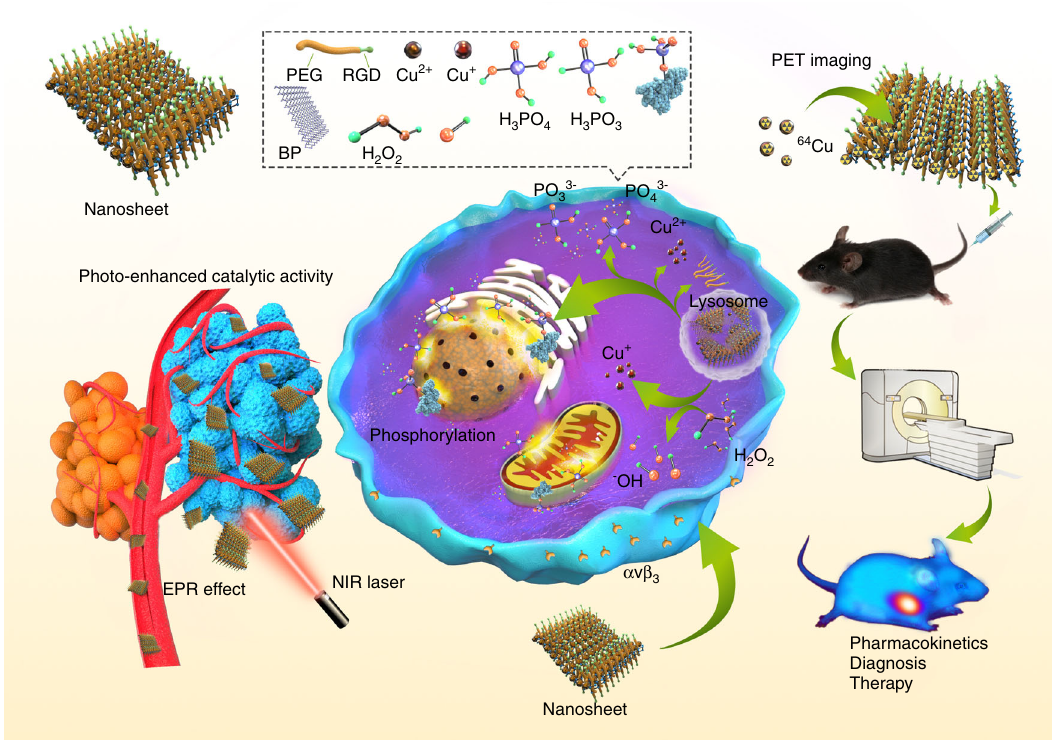
Fig. 1 A multifunctional theranostic platform based on BP@Cu hybrid nanomaterial. Inset box: illustration of the composition and construction of the BPNS-based nanomaterials. The biological responses elicited by the synergistic therapeutic effects of BPNS and Cu ions are illustrated. The BPNS is coupled with 64 Cu radioisotope for PET imaging-guided pharmacokinetics and therapeutic ef fi cacy studies. Abbreviations: EPR enhanced permeability and retention, NIR near-infrared, PET positron emission